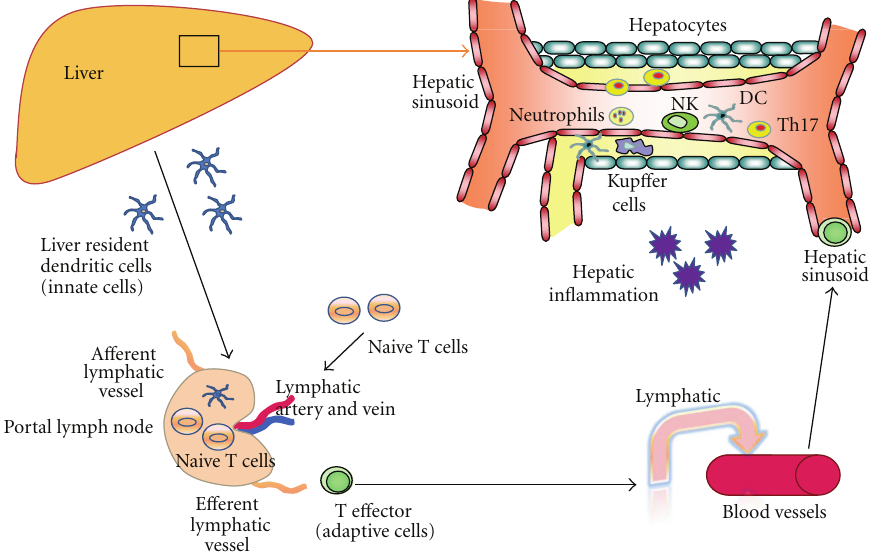
Figure 3: Innate immune cell (neutrophils, NK cells and monocytes) recruitment to hepatic inflammation. Human liver receives dual blood supply from both portal vein and hepatic artery. During the inital event of hepatic inflammation, innate immune cells such as neutrophils, monocytes and NK cells are recruited to the liver. Liver resident dendritic cells sample the foreign antigen and carry to local draining portal lymph nodes where antigens are presented to the adaptive naive T cells. Following the antigen presentation, di ff erent types of antigen-specific T e ff ectors cells leave the nodes and drain back to systemic circulation. These T e ff ector cells recruit via hepatic sinusoid towards the site of injury or inflammation. Th17 cells which secrete IL-17 attract neutrophils and also link innate and adaptive